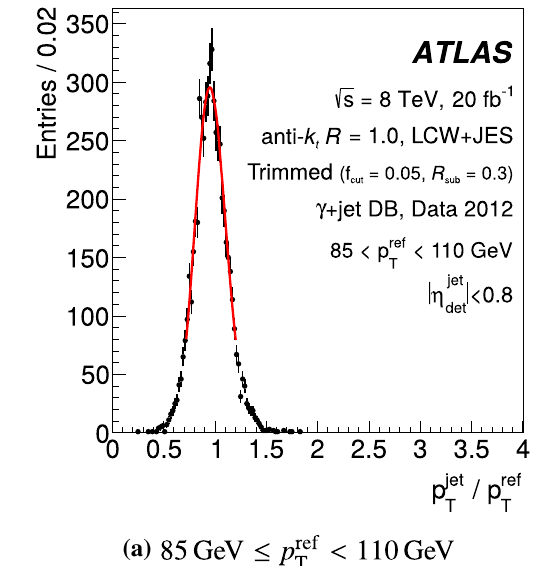
/ p ref Fig. 28 p j1 distributions for events with a 85GeV ≤ p ref T T < 310GeV for trimmed anti- k 110GeV and b 260GeV ≤ p ref T with R = 1 . 0 calibrated with the LCW+JES scheme in data. The lines